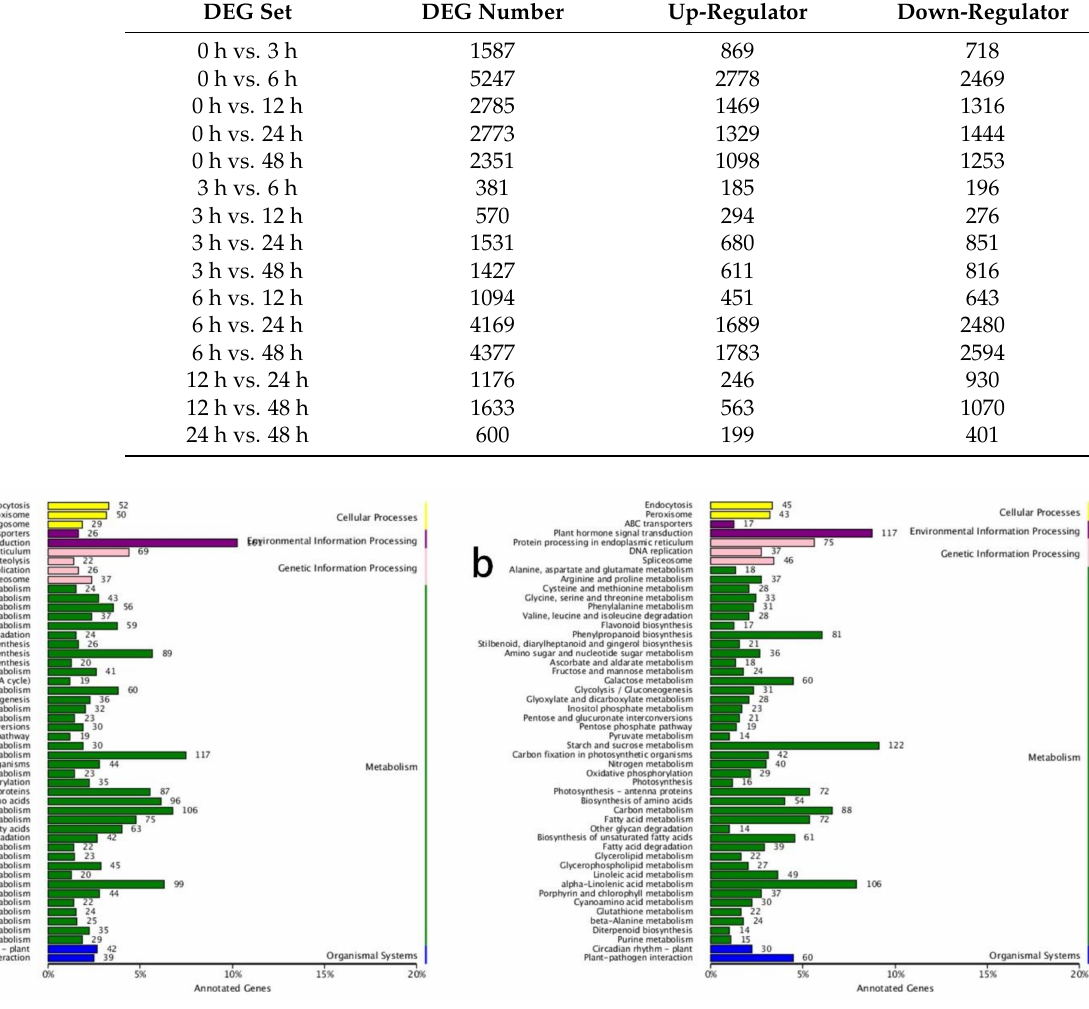
Figure 1. KEGG annotations in the ‘0 h vs. 6 h’ and ‘6 h vs. 48 h’ comparisons. ( a ) KEGG annotations in the ‘0 h vs. 6 h’ comparison; ( b ) KEGG annotations in the ‘6 h vs. 48 h’